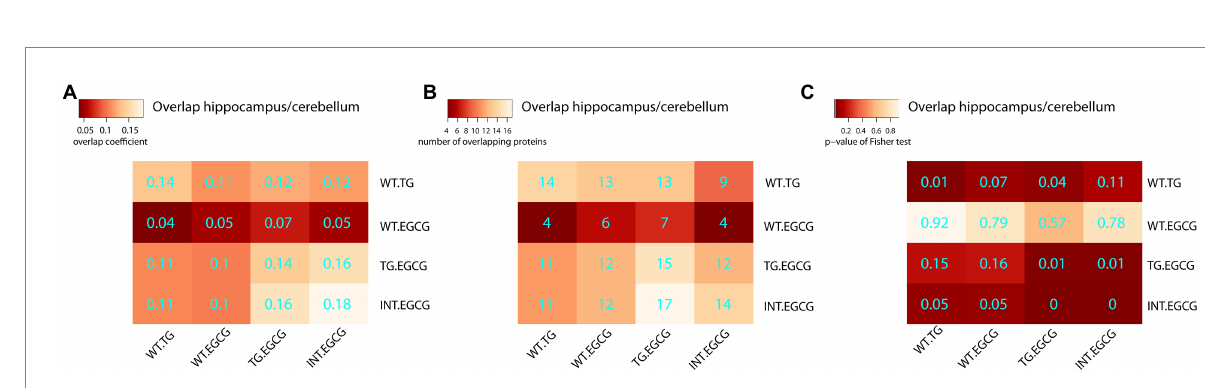
FIGURE 4 Overlaps of differentially abundant proteins across experimental conditions. Heatmap showing the overlap between differentially abundant proteins in the cerebellum and hippocampus. (A) The Szymkiewicz–Simpson overlap coefficient is depicted in cyan; (B) the number of overlapping proteins; (C) the p -values of the exact Fisher test. TG, TG mice. WT, wild-type mice. NT, not treated, EGCG treated with green tea